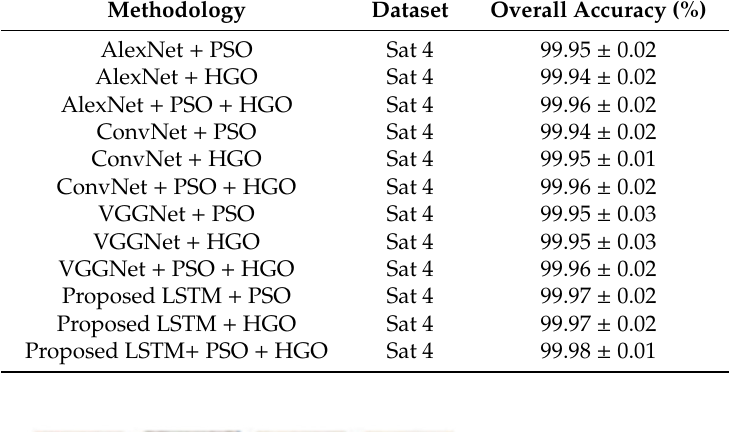
Table 8. Comparative analysis of di ff erent neural networks with PSO and HGO.